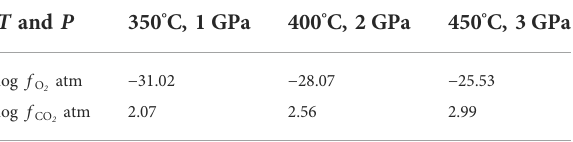
TABLE2Thecalculatedfugacitiesofoxygenandcarbondioxideatthe initial decomposition temperature of siderite at different pressure based on the formula given by Yui (1966). T and